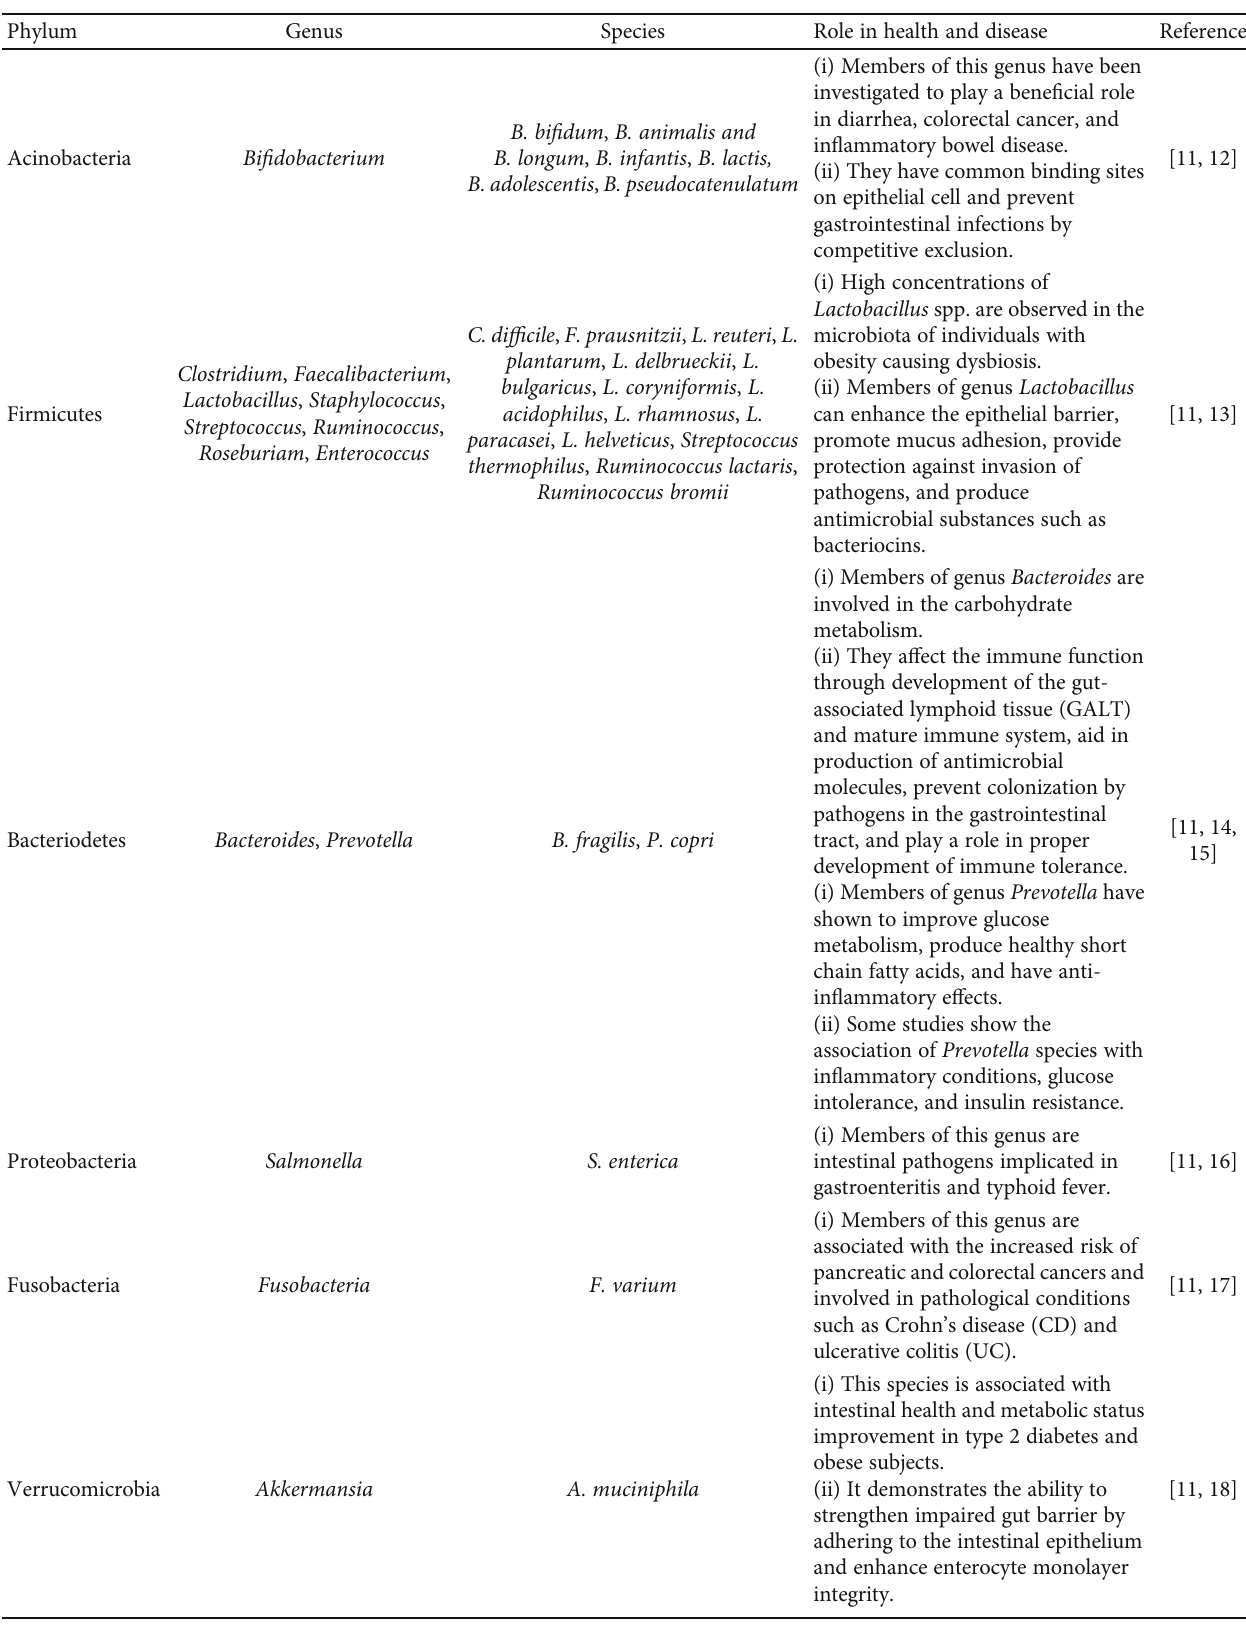
Table 1: Common bacterial species and their role in human